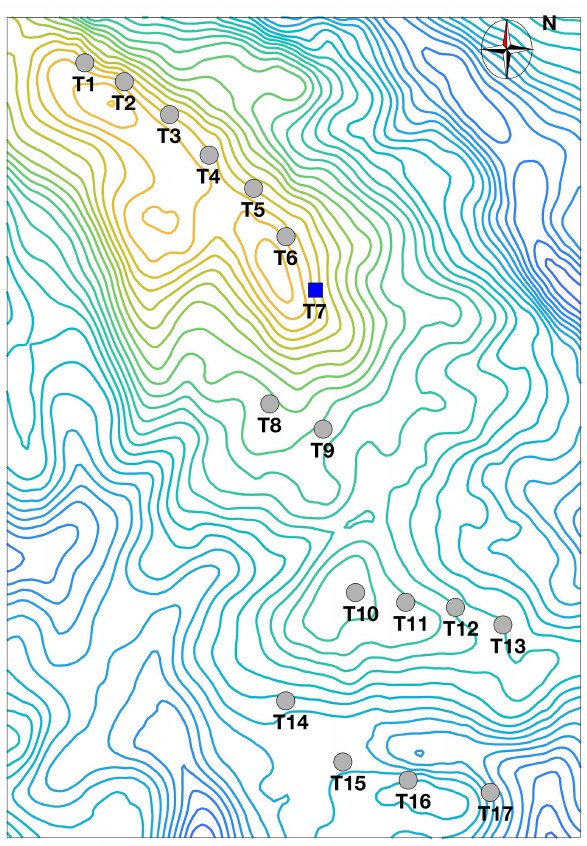
Figure 1. The layout of the wind